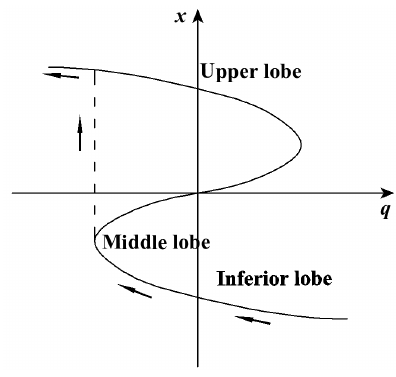
Figure 11. The state jump when leaping over the bifurcation point sets.